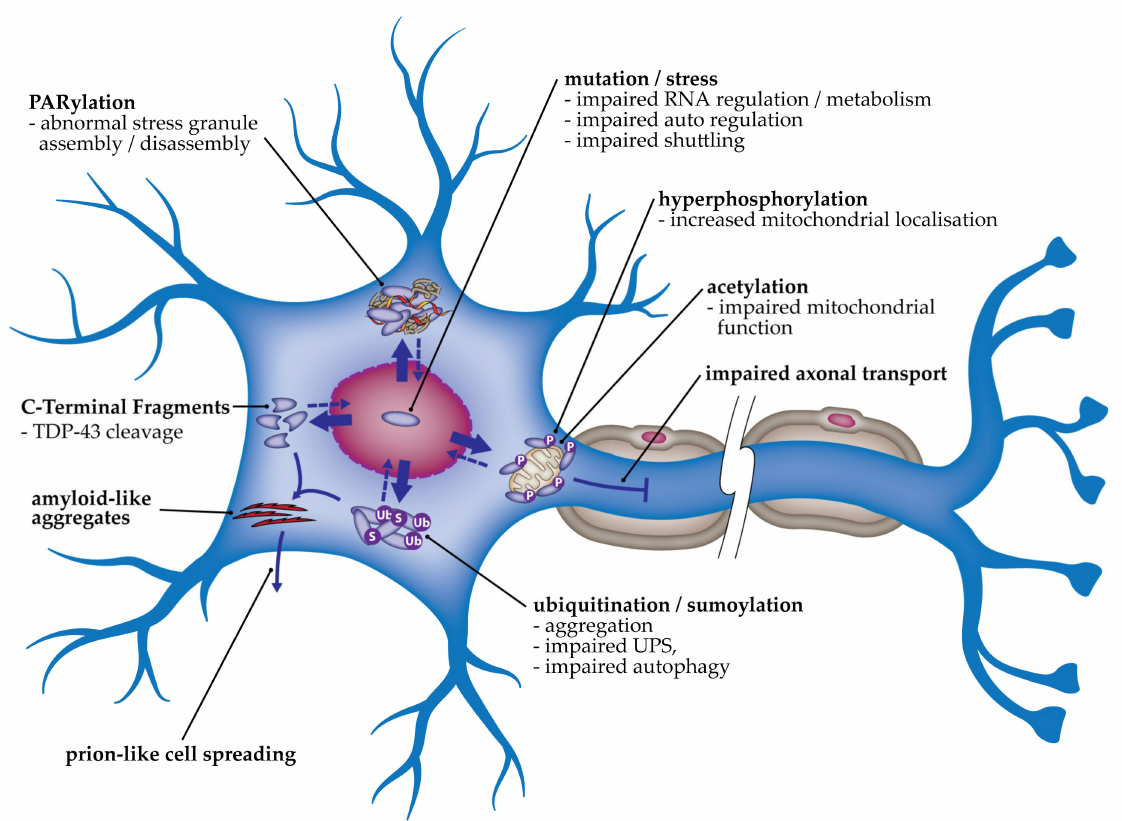
Figure 2. Molecular mechanisms underlying TDP-43 pathogenesis in response to mutations or stress. Mutations in TARDBP or other genes associated with ALS and FTLD, or exposure to oxidative stress or heavy metals such as arsenite, impair TDP-43 function. Specifically, TDP-43 autoregulation and nuclear:cytoplasmic shuttling is impaired, leading to a loss of RNA metabolism and increased cytoplasmic TDP-43. Mislocalization of TDP-43 increases its tendency to aggregate. Post- translational modifications occur including hyper-phosphorylation (P), acetylation, ubiquitination (Ub), SUMOylation (S), or PARylation, as well as cleavage/fragmentation, which promotes TDP-43 aggregation. The nuclear depletion, misfolding and cytoplasmic aggregation of TDP-43 leads to (1) dysregulation of RNA metabolism including splicing defects, (2) impaired mitochondrial function and axonal transport, (3) impaired proteostasis (UPS and autophagy), (4) abnormal stress granule dynamics and (5) amyloid-like aggregate formation that may be spread cell to cell in a prion-like